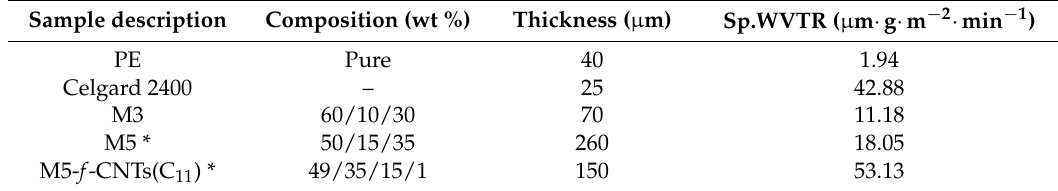
Table 3. Specific water vapor transmission rate (Sp.WVTR) values of the examined membranes.